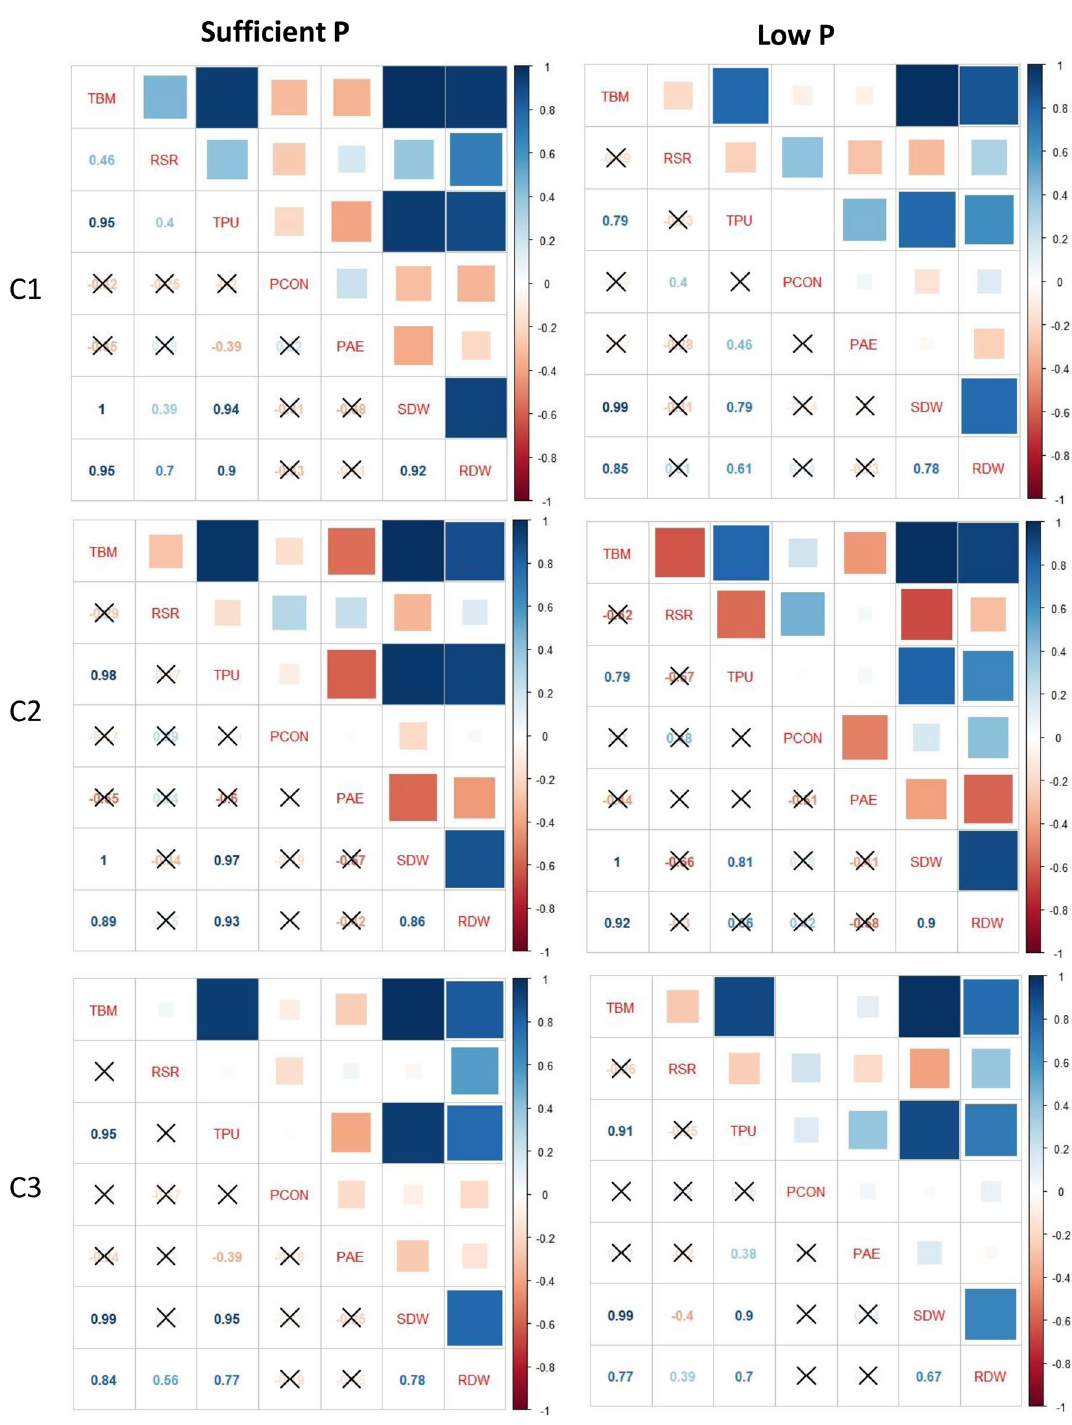
Figure 4. Correlation matrix showing association of three subpopulations, C1, C2, and C3, obtained using SNP markers in 82 diverse wheat accessions and phenotyped under sufficient P and low P concentration in hydroponics. Correlations with p-value > 0.01 are considered as insignificant, such correlation coefficient values are represented with a cross. Abbreviations: TBM, total biomass; RSR, root-to-shoot ratio; TPU, total phosphorus uptake; PCON, phosphorus concentration; PAE, P acquisition efficiency; SDW, shoot dry weight; RDW, root dry